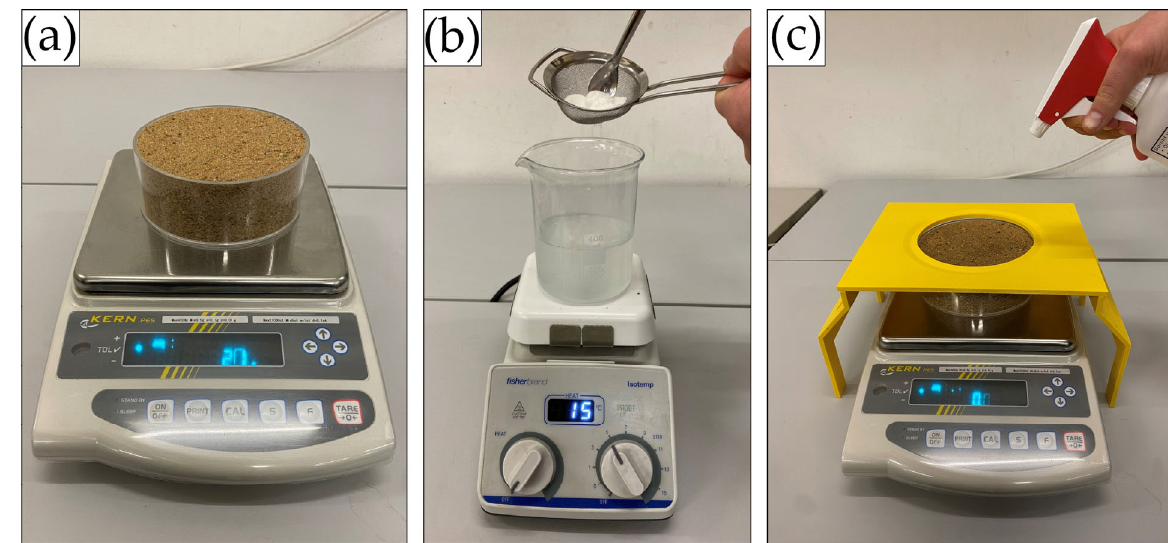
Figure 2. ( a ) Weighing of dry sample, ( b ) preparation of biopolymer solution, ( c ) gravimetric spray-on application of biopolymer solution with splash guard.